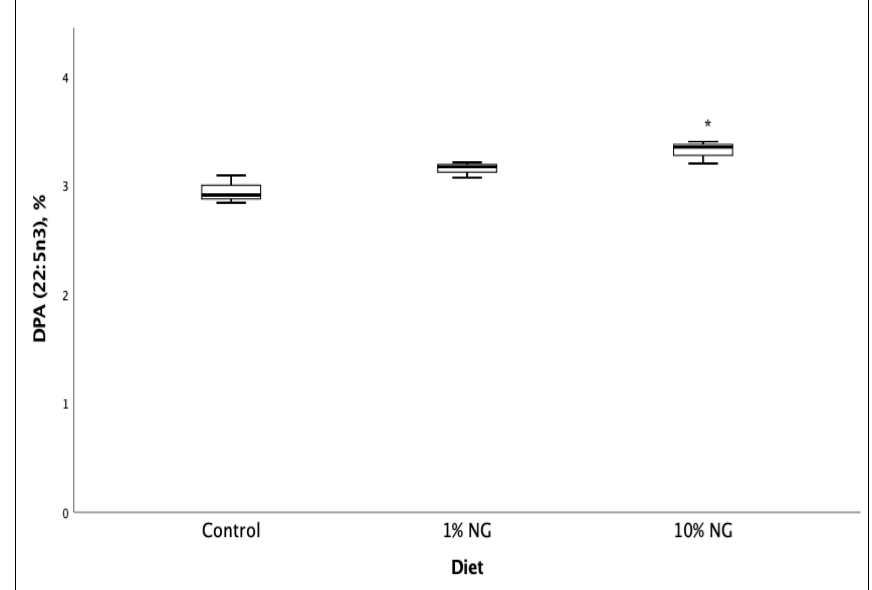
Figure 2. Salmon meat eicosapentaenoic (EPA, 20:5 n-3) fatty acid composition after 49 days of feeding the experimental diets. NG = Nannochloropsis gaditana, * Significantly different from control ( p < 0.05) . Values are based on the mean ± S.D. n = 3.